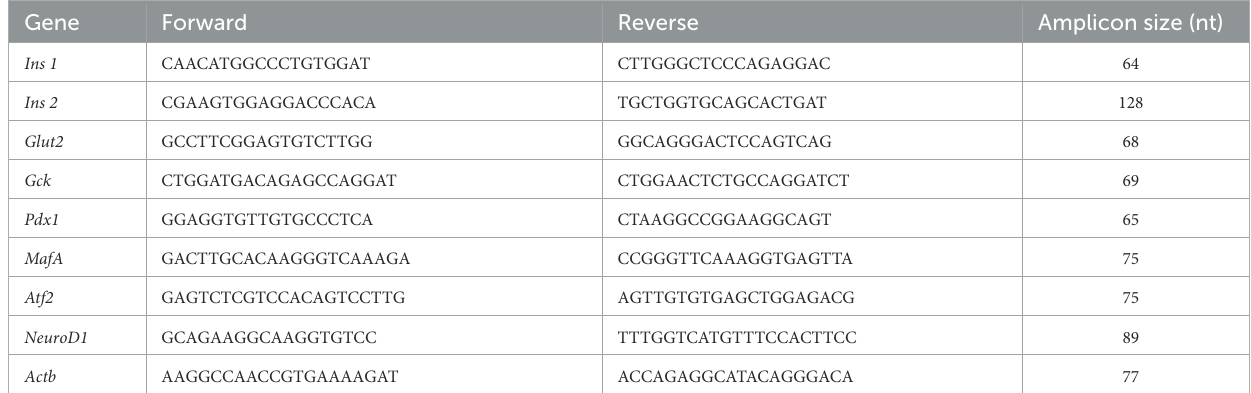
TABLE 2 Oligonucleotide sequences of studied genes.